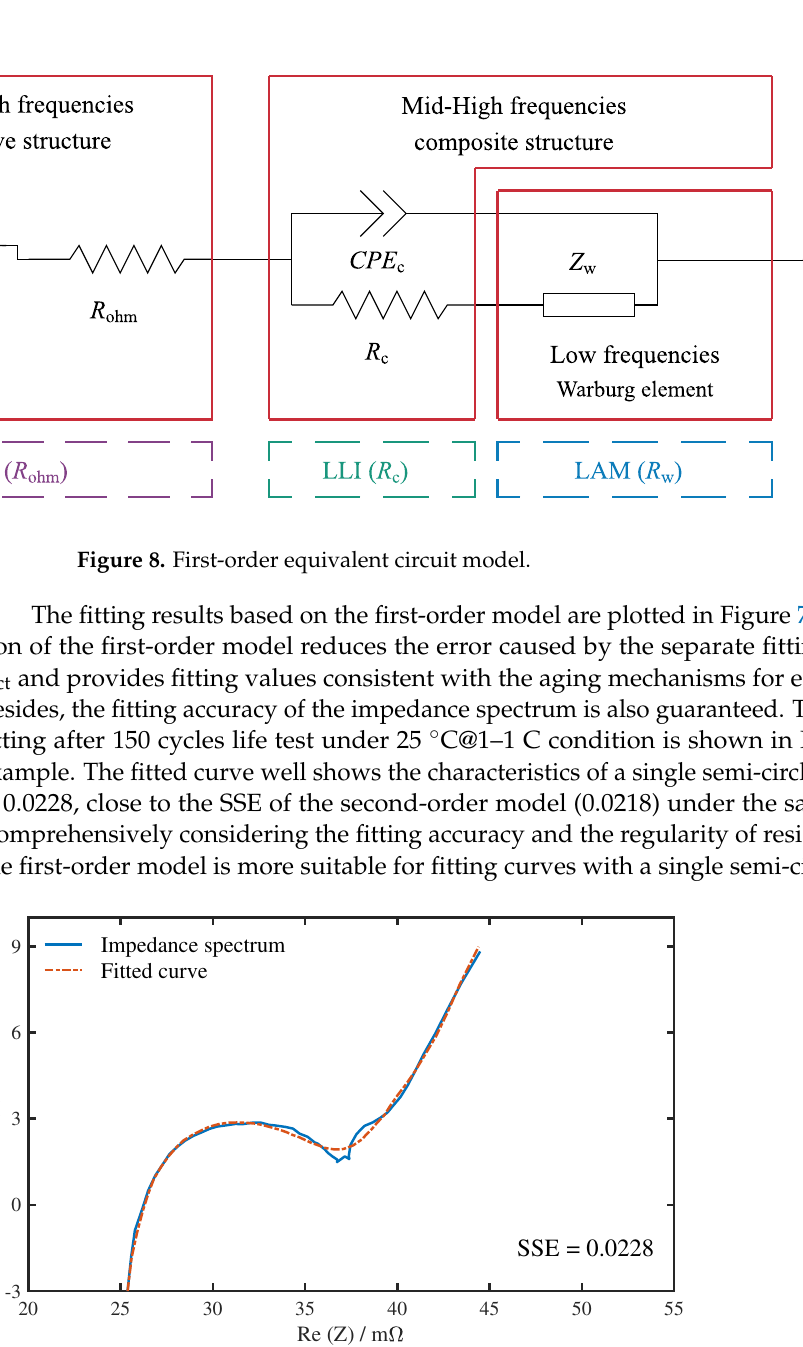
Figure 9. The impedance fitting based on the first-order equivalent circuit model, after 150 cycles